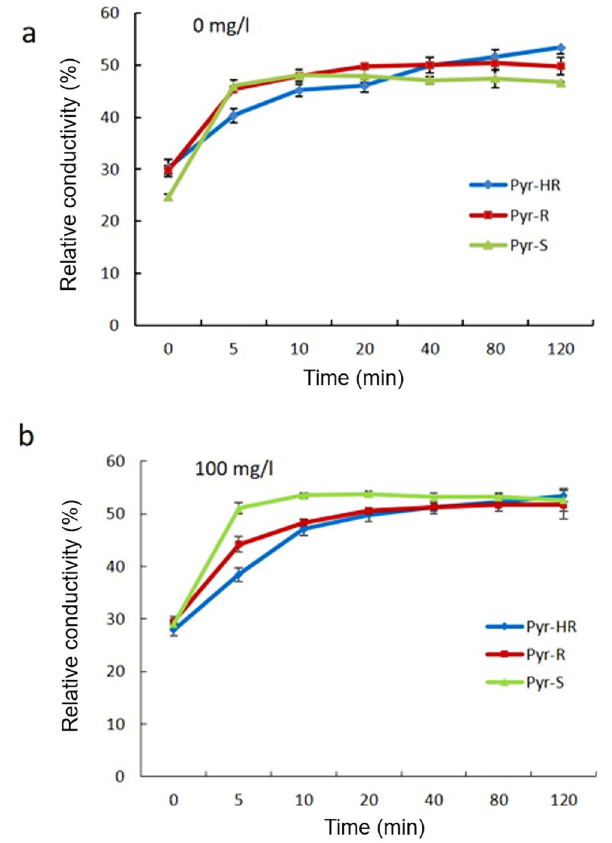
Fig 3. The relative conductivity of Lasiodiplodia theobromae to different pyraclostrobin resistance phenotypes. (a) Treated with no fungicede. (b) Treated with 100 mg/l pyraclostrobin. Bars denote the stand error of three experiments. S = sensitive, R = resistant, and HR = highly